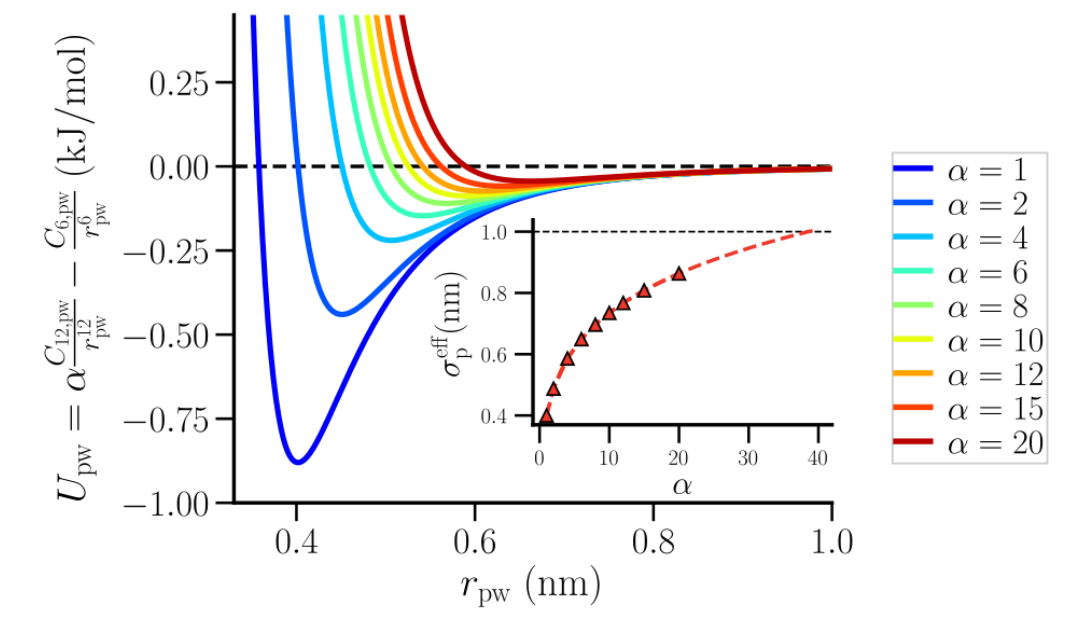
Figure 1. The polymer-water interaction potential, U pw , at various repulsive interaction strength, α